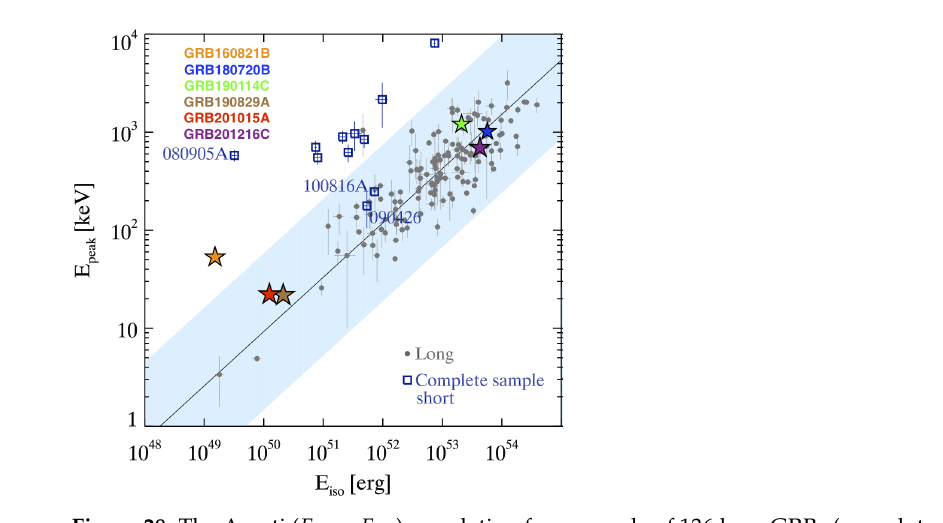
Figure 28. The Amati ( E peak – E iso ) correlation for a sample of 136 long GRBs (grey dots, from [230]) and a sample of 11 short GRBs (empty blue squares) detected by Swift. The corresponding power-law fit for the sample of long GRBs and the 3 σ scatter of the distribution of points around the best fits are shown. The six GRBs detected in VHE are also added in the plot. Adapted from